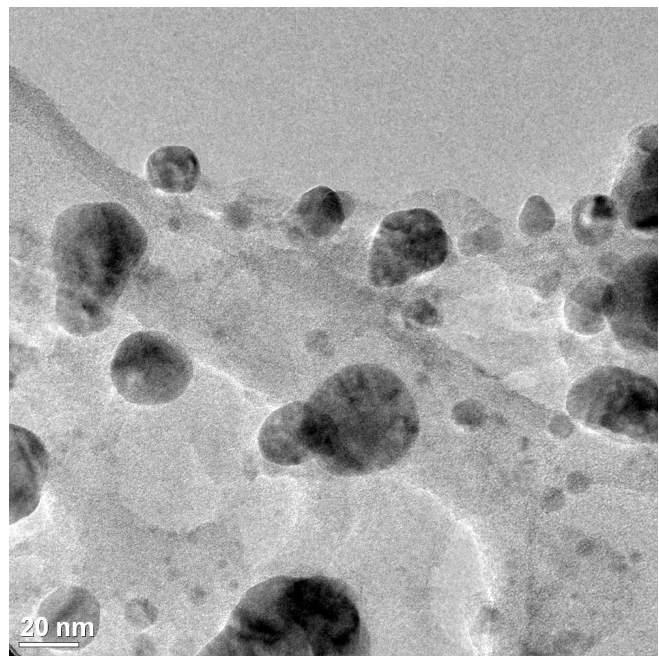
Figure 2. Spherical morphology and diameters between 20 and 50 nm of copper nanoparticles (Cu NPs) determined by transmission electron microscopy (TEM).